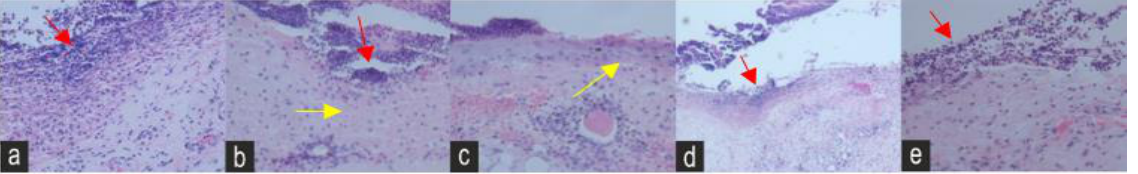
Figure 6. Histopathology sections of the ( a ) negative control (NEG) ( b ) positive control (POS) ( c ) Naringin (NAR) ( d ) Eicosane (EIC) and ( e ) Octacosane (OCT) groups on day 2 under an x40 magni- fication. The red arrows indicate PMNL cells; the yellow arrows indicate keratinocyte migration.